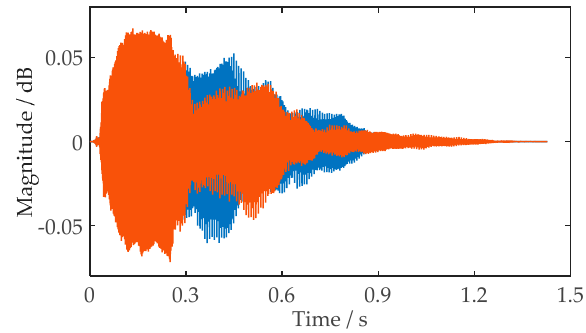
Figure 9. The waveform of original notify signal in time domain, the orange curve and blue curve stand for the data in different channels, respectively.